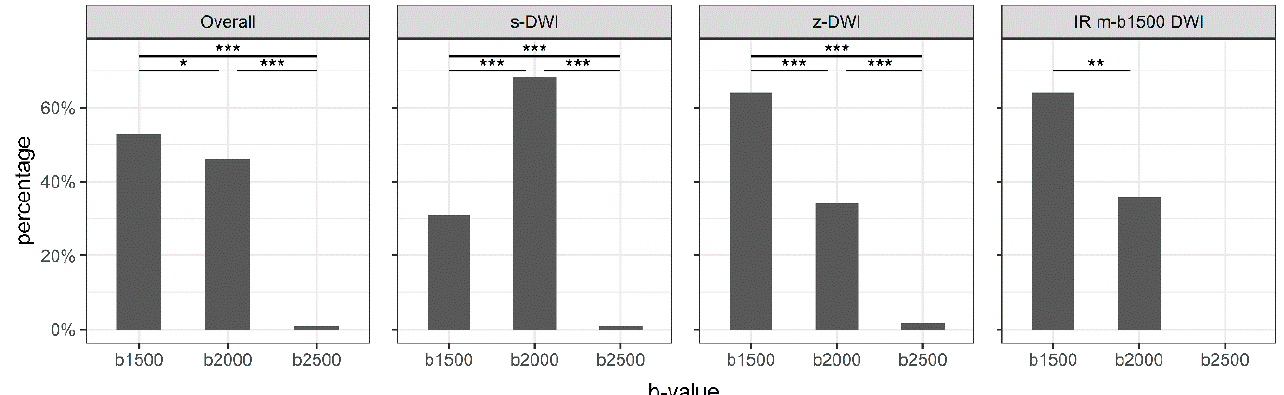
Figure 2. Preferred b-values for the different sequences. The preferred b-value is dependent on the sequence. s-DWI: single-shot echo-planar DWI; z-DWI: zoomed DWI with spectral-attenuated inversion-recovery fat saturation; IR m-b1500 DWI: DWI with improved inversion-recovery fat saturation. * = 0.01 < p ≤ 0.05; ** = 0.001< p ≤ 0.01; *** = p ≤ 0.001.